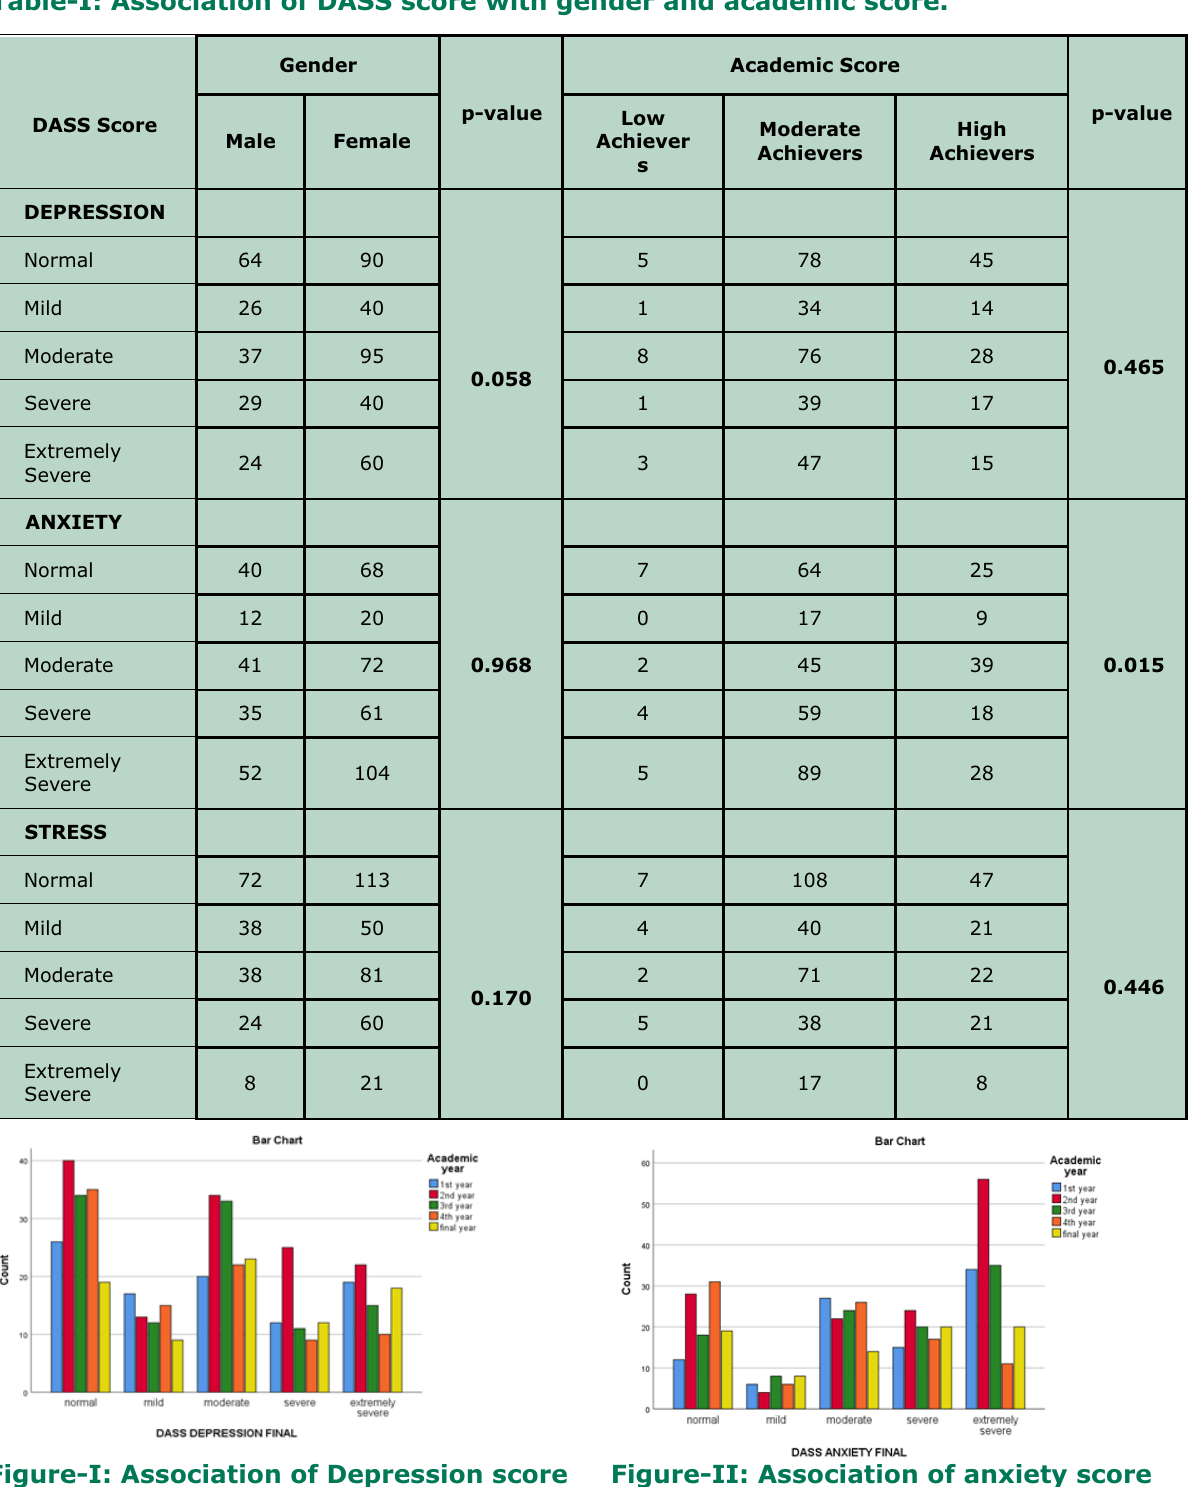
Figure-I: Association of Depression score with academic year. 2 x = 18.78, df= 16, p= 0.28